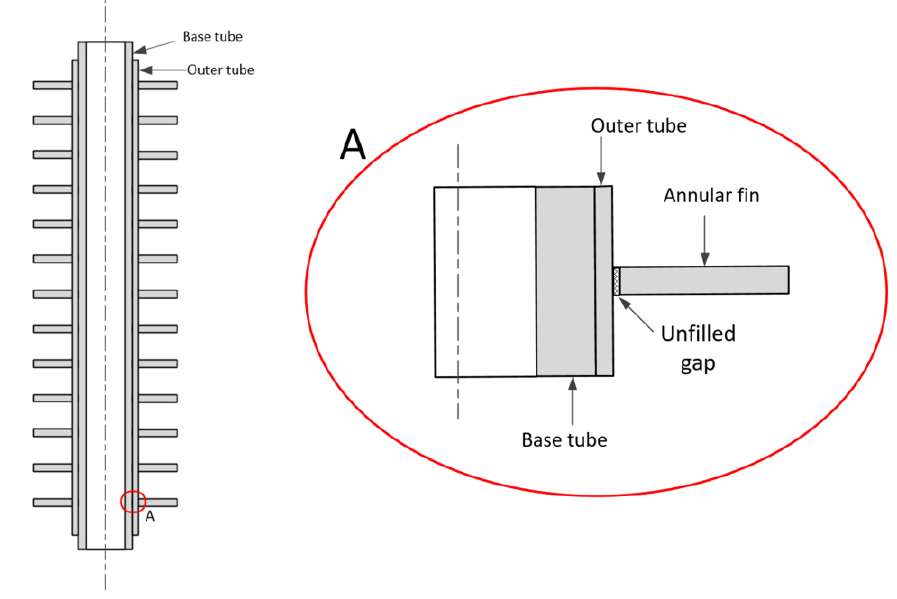
Figure 3. Annular finned tube used in the study of Liu [5] with unfilled gaps between the base tube and fins.